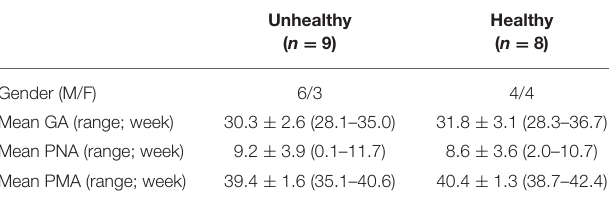
TABLE 1 | Demographic features of